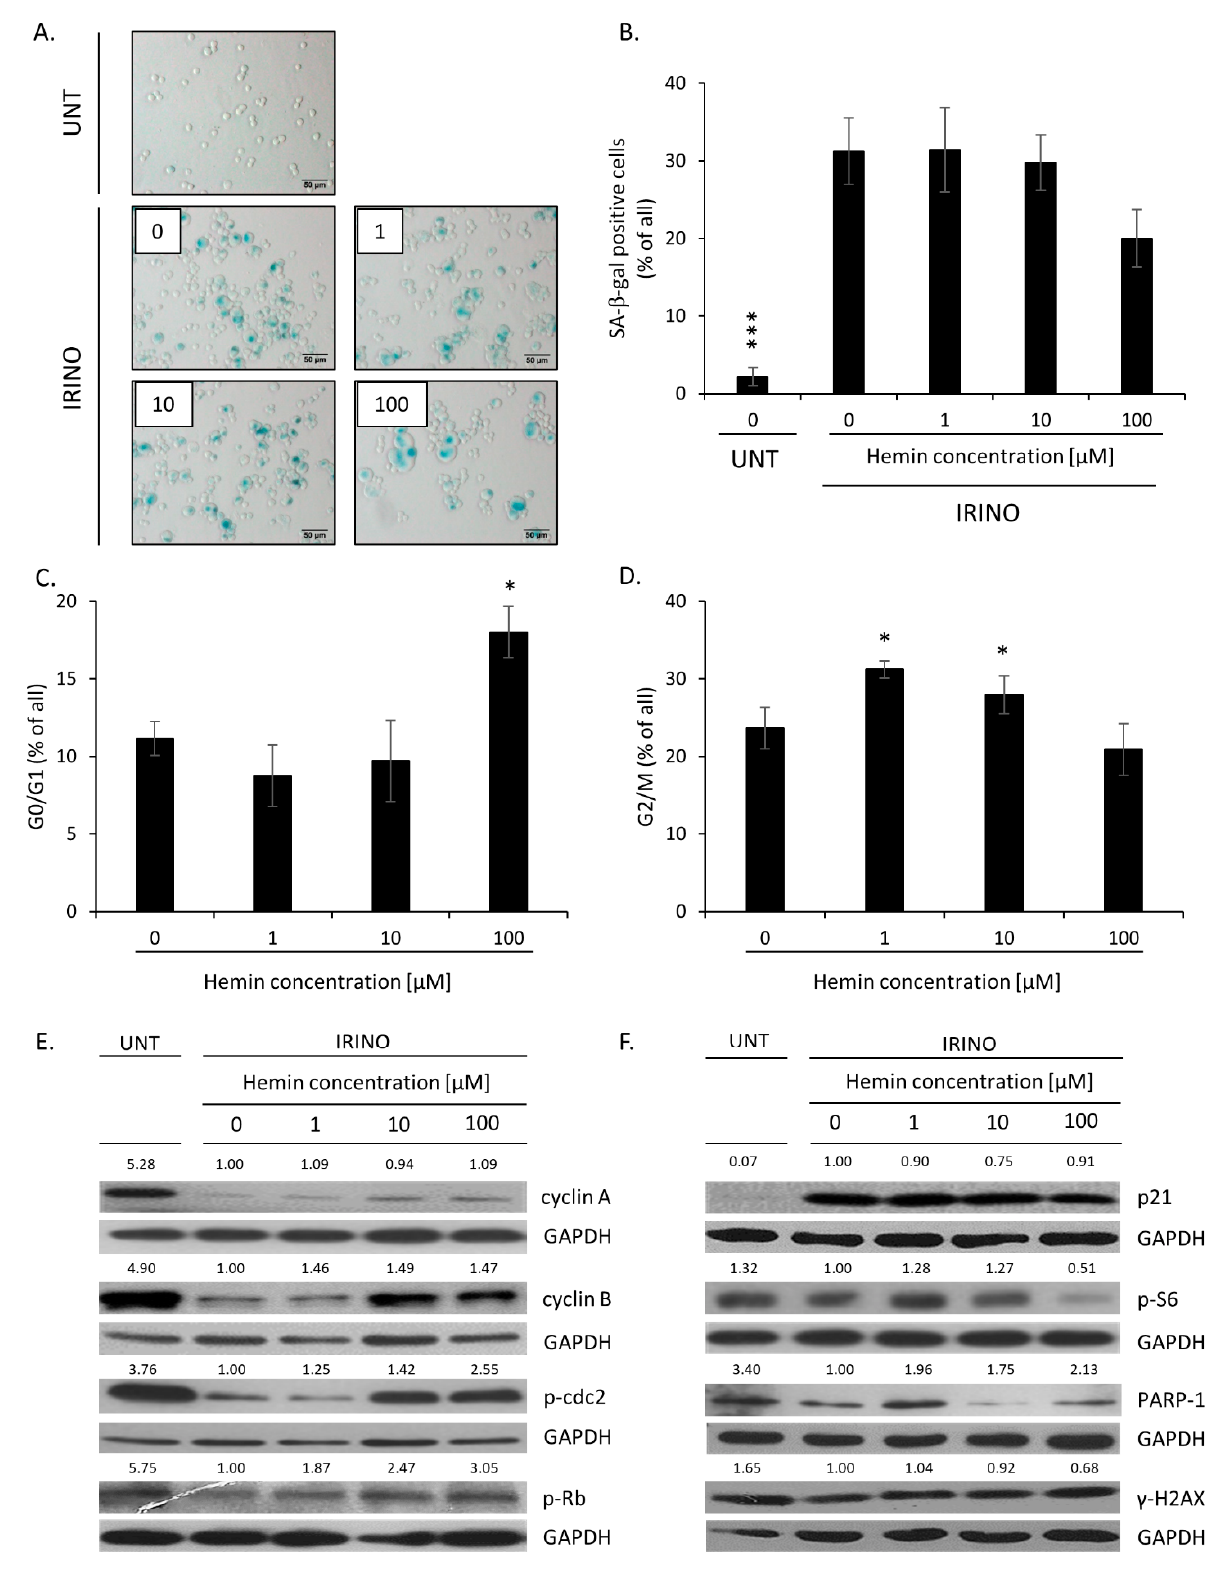
Figure 2. High hemin concentration correlates with an escape from senescence. ( A ) The activity of the SA- β -Gal enzyme in UNT and IRINO-treated cells subjected to hemin. Detection of the enzyme was performed on cytospined cells. Representative photos were acquired using light microscopy. Original magnification 200×, scale bar 50 µM; ( B ) Quantification of SA- β -Gal positive cells after treatment with hemin; ( C , D ) Quantification of the percentage of cells in the G0/G1 phase ( C ) and the G2/M phase ( D ). Cell cycle analysis was performed with the use of Muse TM Cell Cycle Reagent